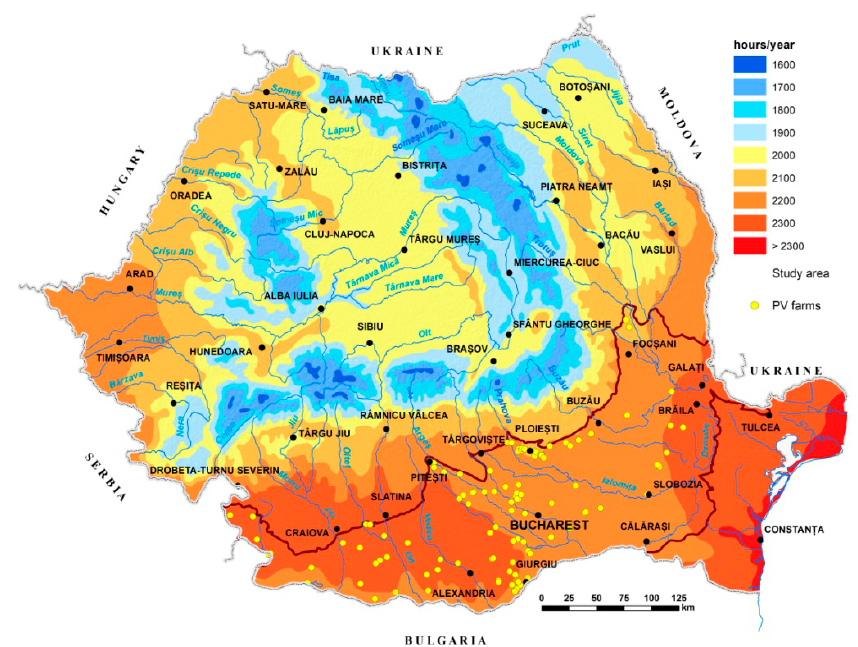
Figure 2. Annual sunshine duration in Romania [39] and the spatial distribution of photovoltaic (PV) farms in the study area (authors’ processing).